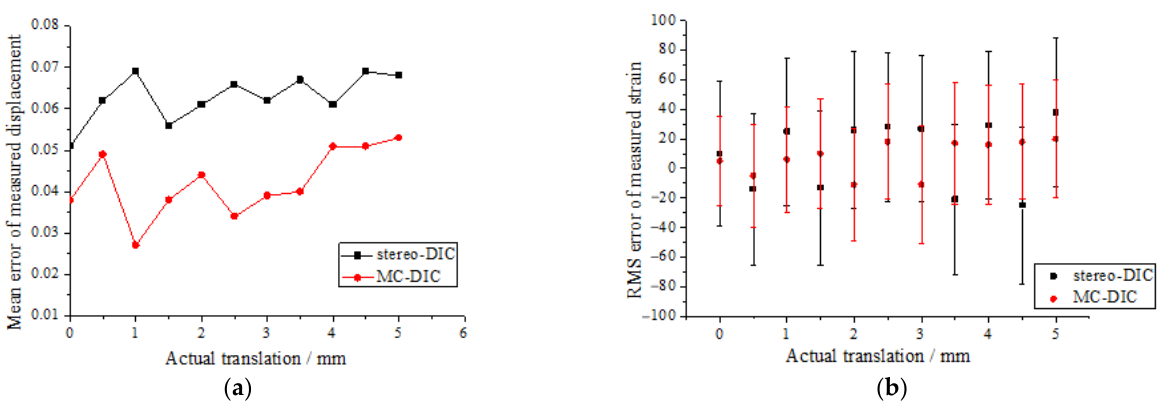
Figure 5. ( a ) Mean errors of the measured displacements by two systems; ( b ) RMS errors of the measured strains by two systems.